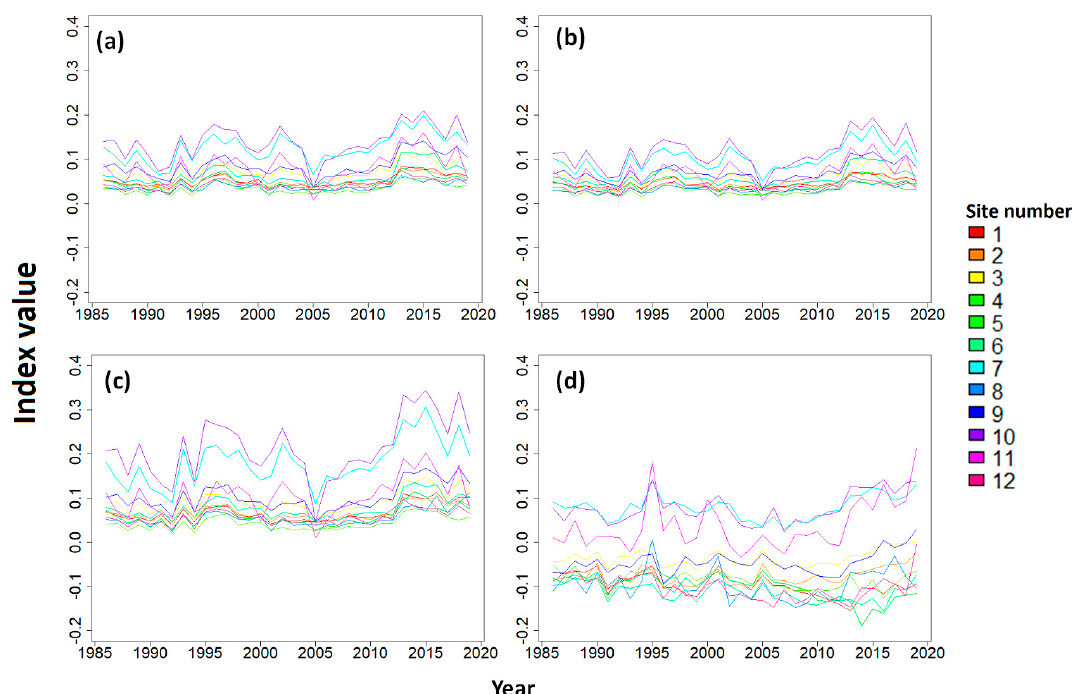
Figure 7. Time series between 1986 and 2019 extracted from different mangrove sites (for all four indices: ( a ) EVI, ( b ) MSAVI, ( c ) NDVI, and ( d ) NDMI.